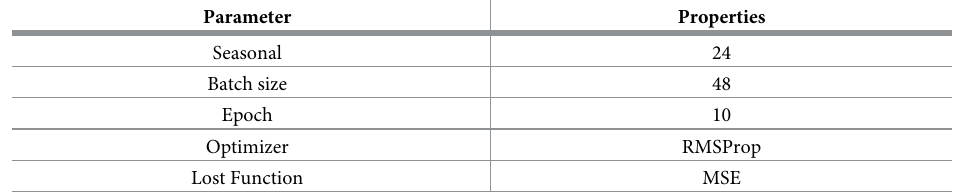
Table 1. Hyperparameters for hourly prediction